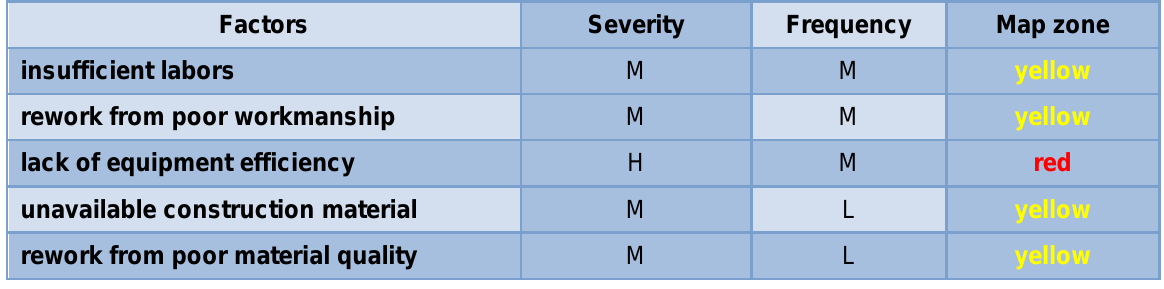
Table 7 Risk map for factors under construction items group The Critical